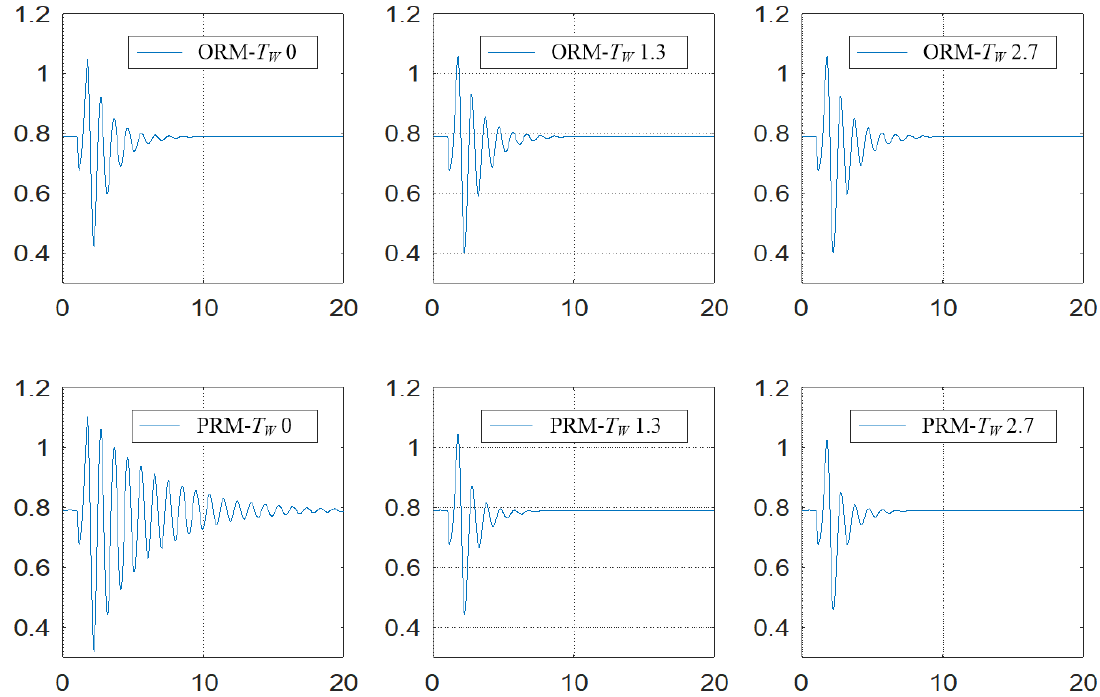
Figure 9. Response of power angle δ under three-phase short circuit.